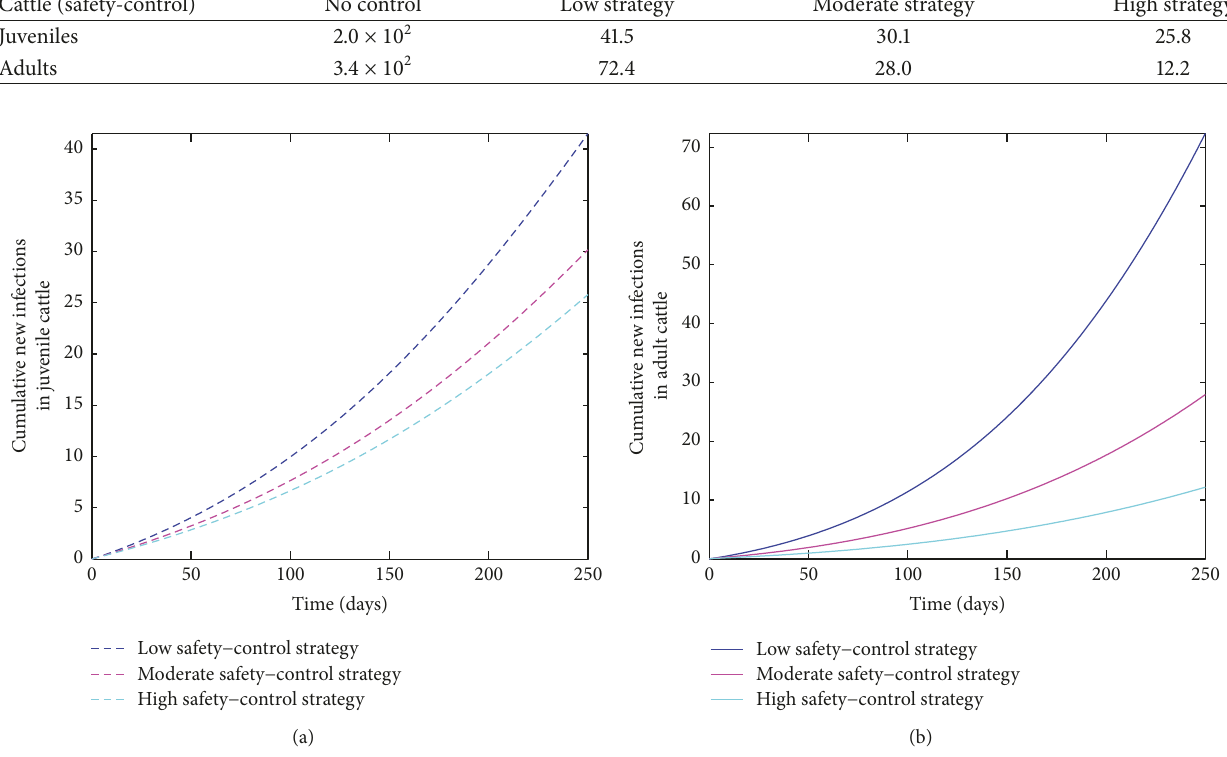
Figure 7: Simulation of the bovine anaplasmosis model (12) as a function of time using the safety-control strategy. (a) Cumulative new infections in juvenile cattle; (b) cumulative new infections in adult cattle.